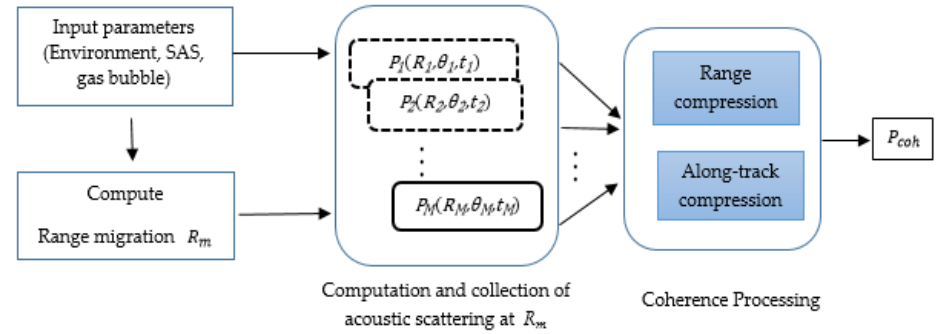
Figure 6. Block diagram of the proposed method. According to the input parameters, the range migration during the synthetic aperture is calculated and then the acoustic scattering fields of the target scene (gas bubble and pipeline) as ( R m , θ m ,t m ) at M different positions of the sonar on the target scene are calculated and stored. Finally, considering the phase difference, all the scattering fields are cohesively combined and the ensemble scattering pressure is obtained .